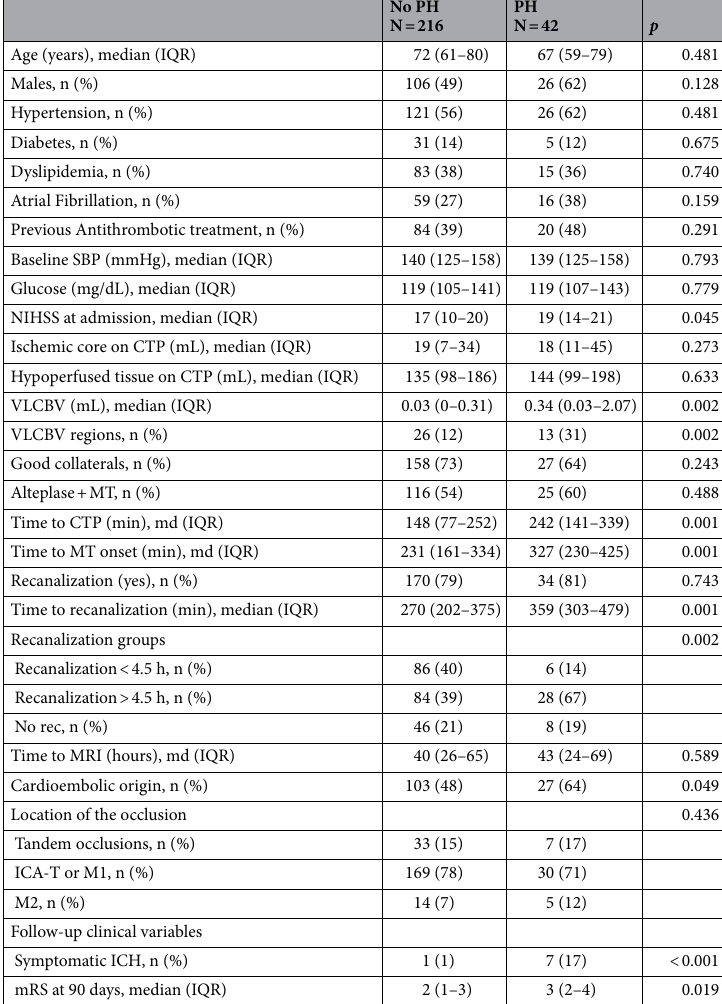
Table 1. Demographics, baseline and procedure related variables according to the occurrence of parenchymal hematoma. ASPECTS Alberta Stroke Program Early CT Score, CTP computed tomographic perfusion,